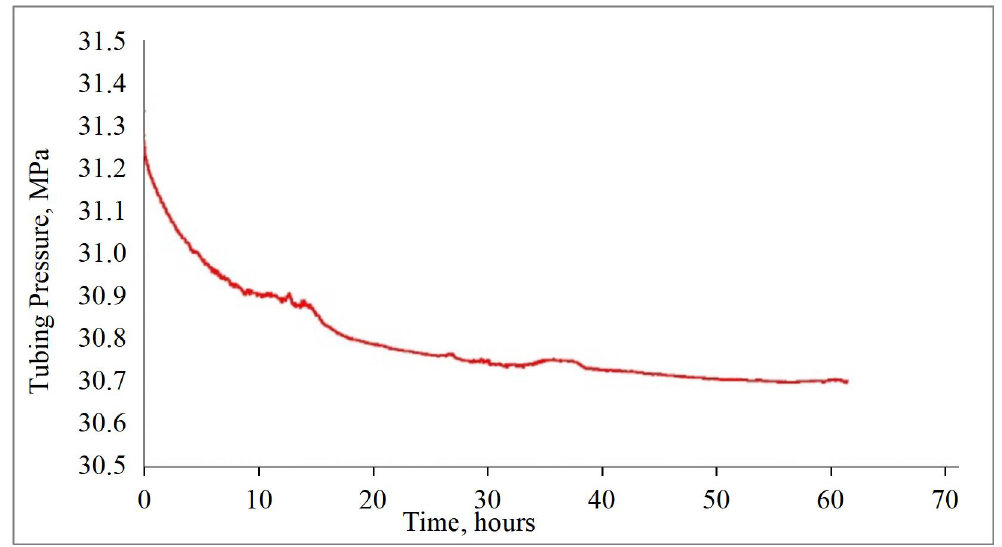
Figure 3—Change of tubing pressure at wellhead during shut-in period after stable